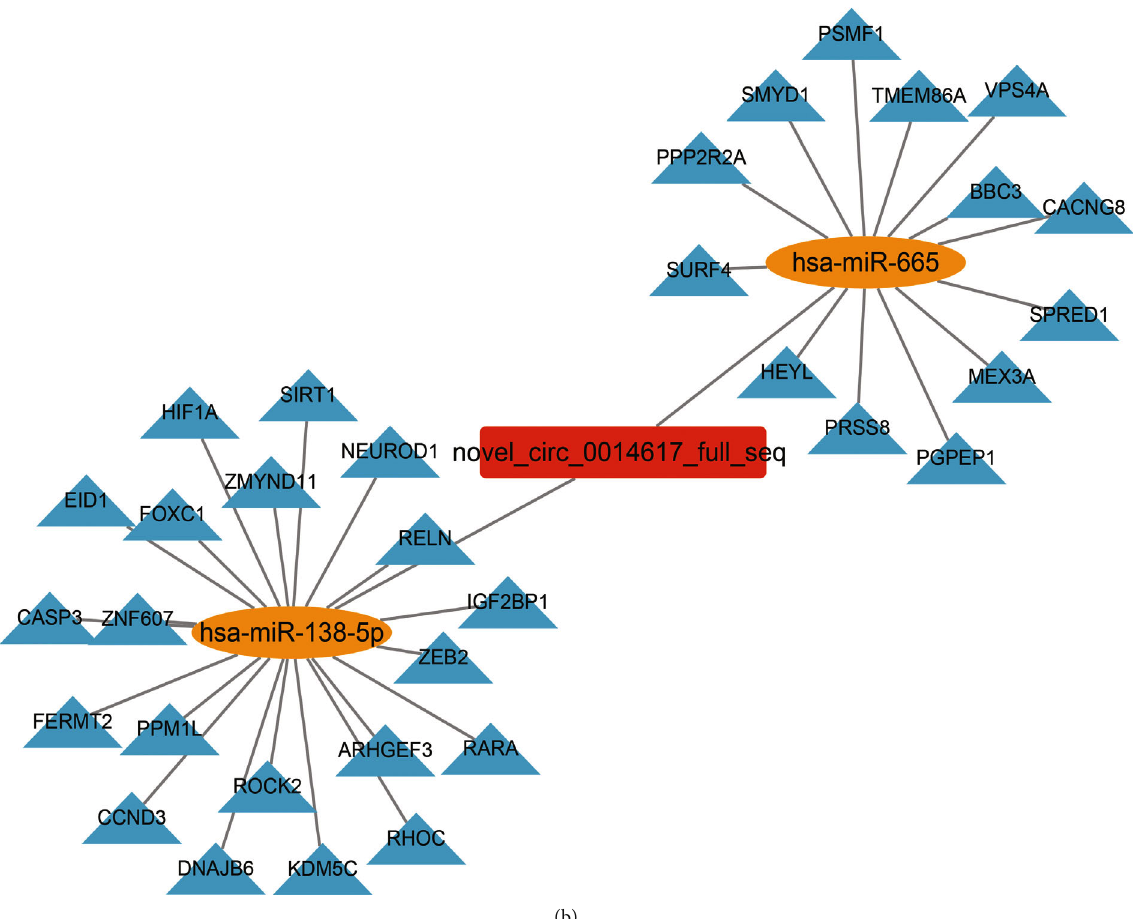
Figure 5: Construction of the circRNA – miRNA – mRNA interaction network. (a) Network of circRNA hsa_circ_0008378. (b) Network of circRNA